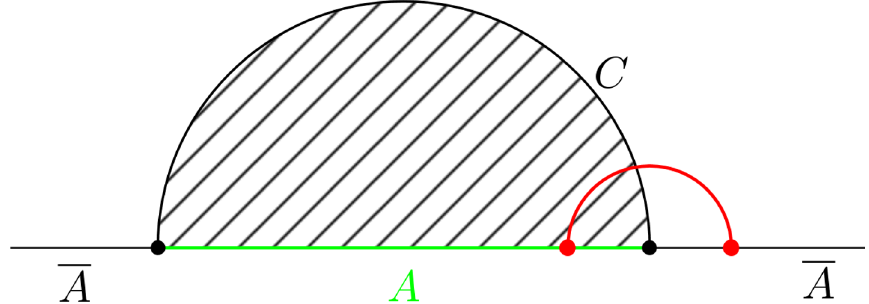
Figure 5 . We consider the subregion A of the boundary indicated by a green line. The entanglement wedge of A is the area C which is shaded. A bilocal excitation, given be the two red points on the boundary, is localized on the red semicircle in the